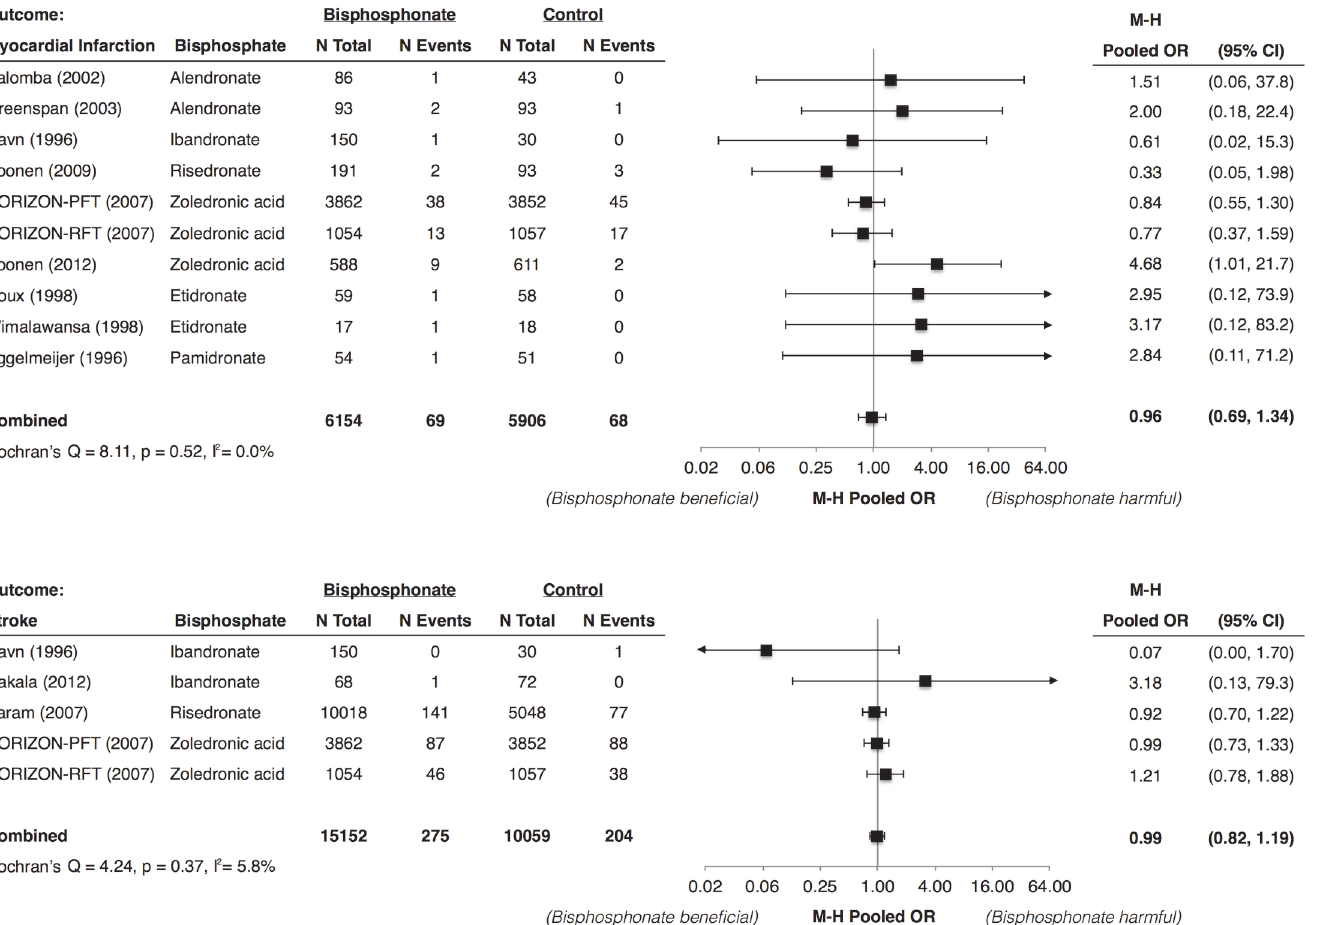
Fig 4. Meta-Analysis of Myocardial Infarction and Stroke with Use of Bisphosphonates. * Abbreviations: CI, confidence interval; HORIZON-PFT, the Health Outcomes and Reduced Incidence with Zoledronic Acid Once Yearly Pivotal Fracture Trial; HORIZON-RFT, the Health Outcomes and Reduced Incidence with Zoledronic Acid Once Yearly Recurrent Fracture Trial; M-H, Mantel Haenszel; OR, odds ratio. * Karam (2007) et al. included data from 6 trials of risedronate. Individual study data were not